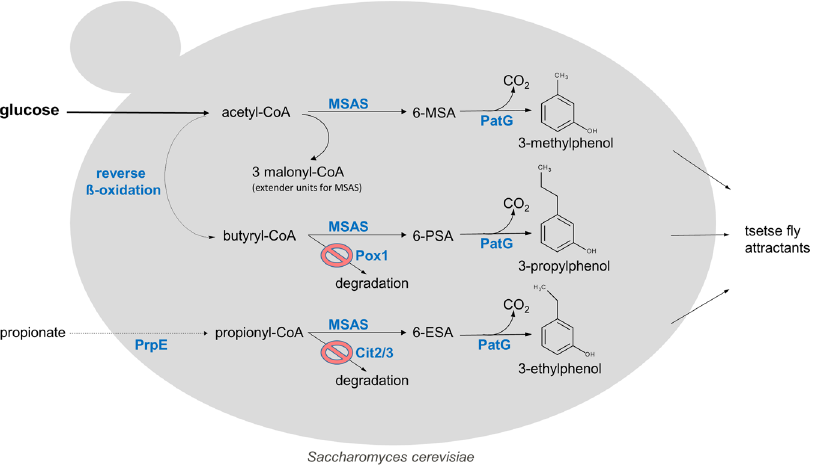
Figure 1. Metabolic pathways for 3-alkylphenol production in S. cerevisiae . In S. cerevisiae the heterologous polyketide synthase MSAS, activated by phosphopantetheinyl transferase (NpgA), catalyses the formation of 6-methylsalicylic acid (6-MSA) utilizing malonyl-CoA as extender unit and acetyl-CoA as priming unit. Intracellular propionyl-CoA can be increased by expression of a bacterial propionyl-CoA synthase (PrpE), propionate feeding and deletion of (methyl) citrate synthase genes CIT2/3 to abolish its degradation. MSAS can then utilize propionyl-CoA as priming unit to catalyse the formation of 6-ethylsalicylic acid (6-ESA). The heterologous ‘reverse ß-oxidation’ pathway 21,22 is providing the priming unit butyryl-CoA from acetyl- CoA for the formation of 6-propylsalicylic acid (6-PSA). Finally, 6-MSA decarboxylase (PatG) converts the 6-alkylsalicylic acids, 6-MSA, 6-ESA or 6-PSA, to their respective 3-alkylphenols (3-methylphenol, 3-ethylphenol or 3-propylphenol) that are valuable tsetse fly